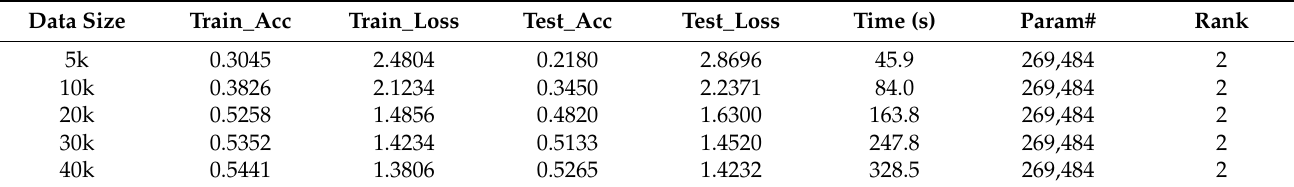
Table 5. Specific parameters and experimental results of the CNN model.